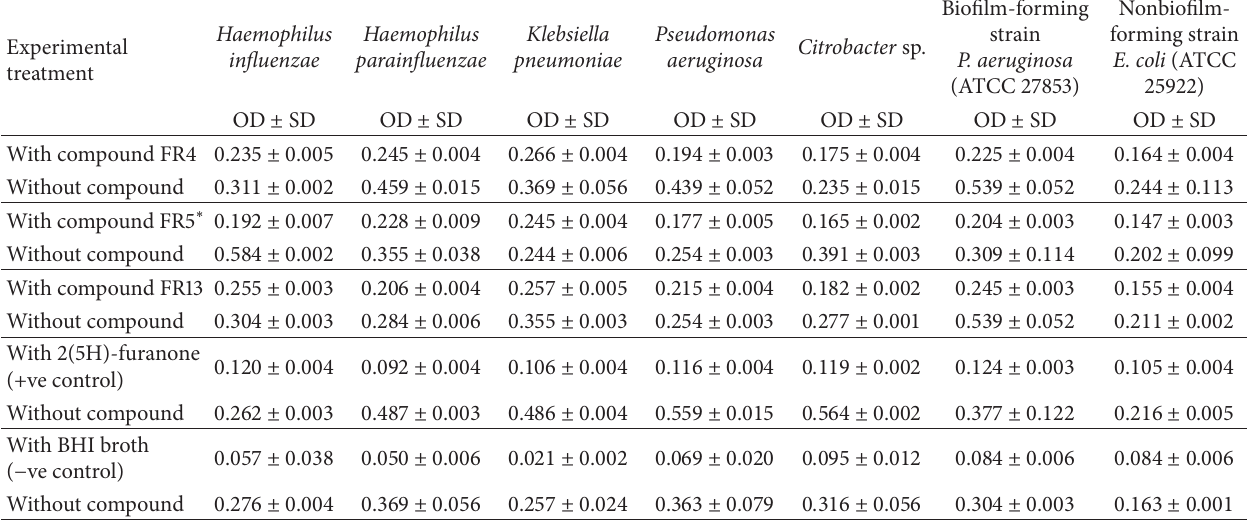
Table 1: Antibiofilm activity of potential compounds of 139SI against Gram-negative clinical isolates.